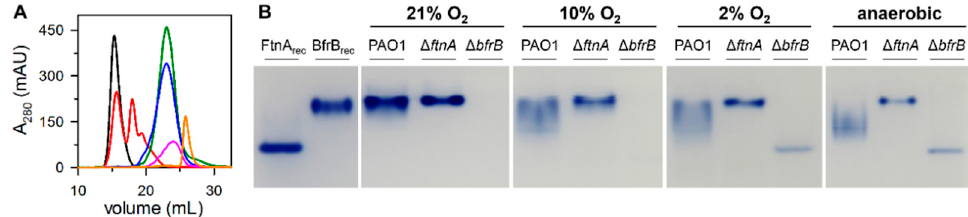
Figure 5. ( A ) Overlay of chromatographic traces from injecting a high-resolution anion exchange column (Source TM 15Q) with pure bacterioferritin solutions isolated from P. aeruginosa PAO1 cells cultured aerobically (21% O 2 red), in 10% O 2 (blue), in 2% O 2 (green), and anaerobically (pink). The black trace corresponds to Bfr isolated from Δ ftnA cells cultured in 21% O 2 and the orange trace corresponds to FtnA rec . ( B ) Lysate solutions of PAO1, Δ ftnA and Δ bfrB cells cultured under distinct O 2 levels in LB media supplemented with 30 µM Fe were separated in a native gel and stained with Ferene S.